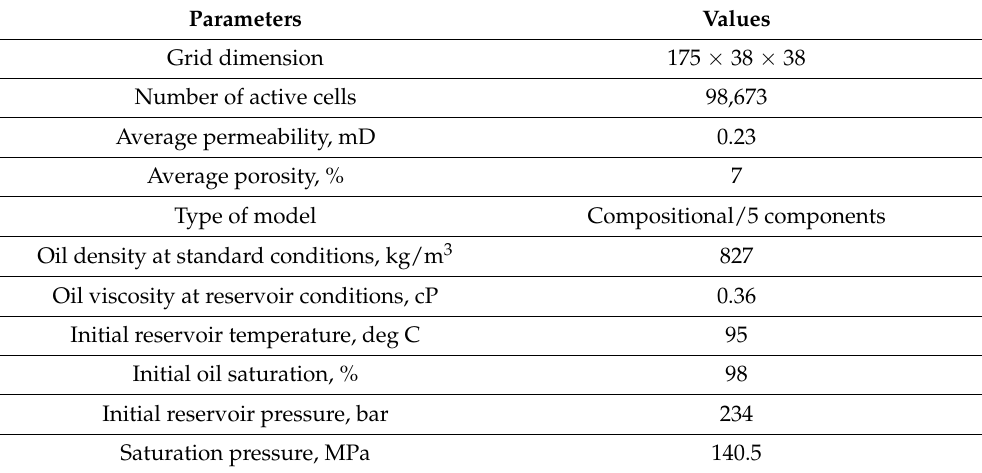
Figure 1. Hydrodynamic model of a well with nine hydraulic fractures for the NTG cube. Table 1. Properties of the model.